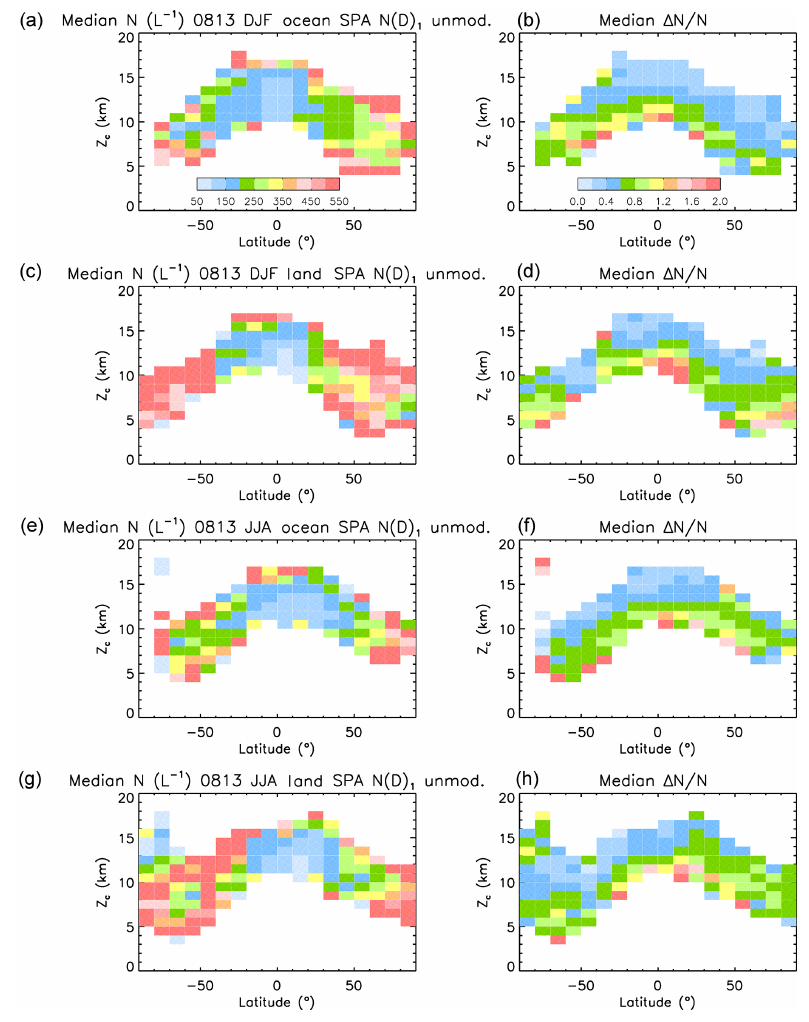
Figure 9. Median ice-particle number concentration N (L − 1 ) retrieved from the SPARTICUS relationships assuming N(D) 1 unmodified (a, c, e, g) and associated relative uncertainty (cid:49)N/N (b, d, f, h) vs. latitude and representative cloud altitude, Z c , during 2008 and 2013. Panels from top to bottom are for DJF over oceans, DJF over land, JJA over oceans, and JJA over